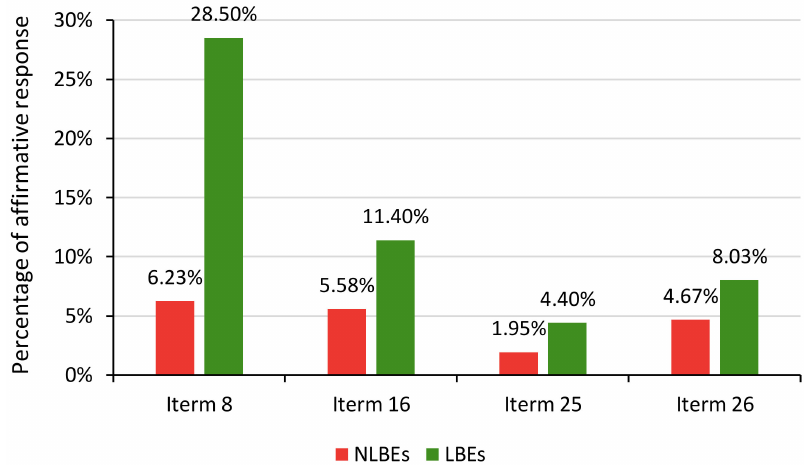
Figure 2. Percentages of affirmative responses to the UPI’s four key items in two main subgroups.